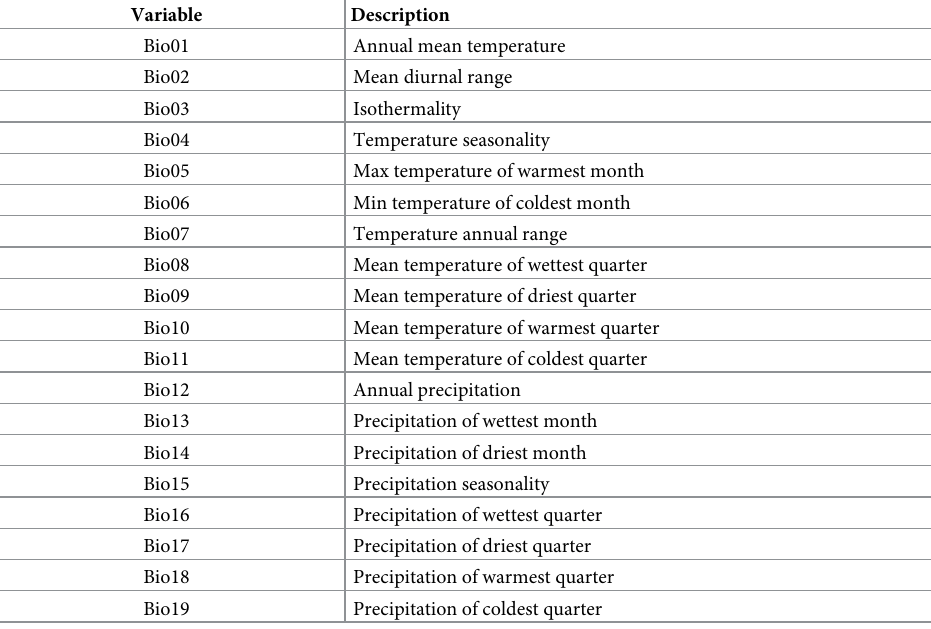
Table 1. WorldClim covariates used in the